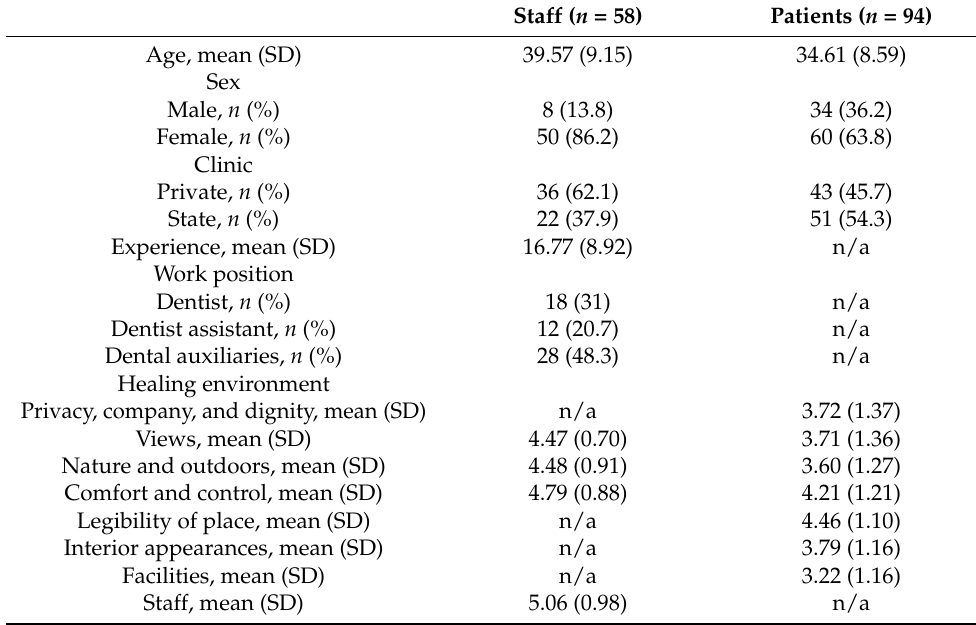
Table 1. Participants and descriptive